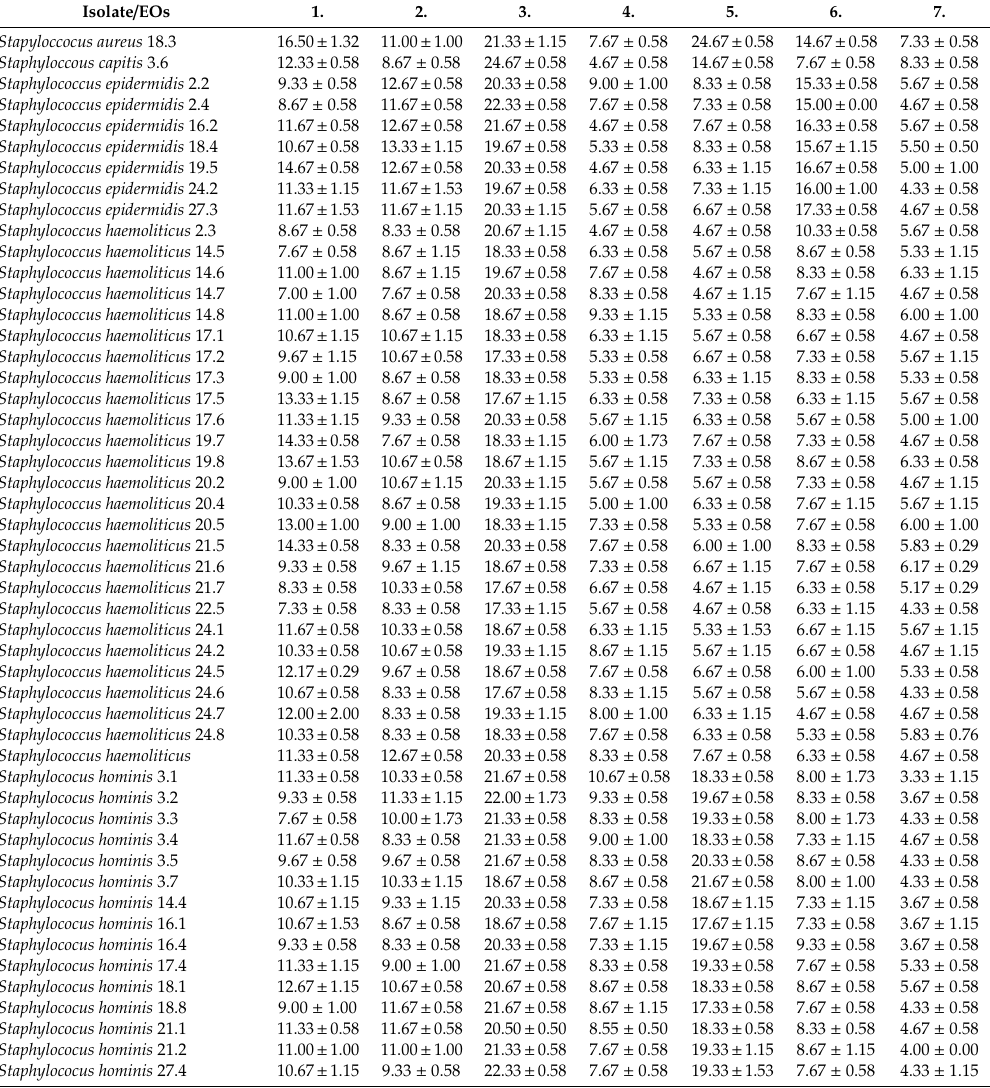
Table 3. Antimicrobial activity of essential oils (EOs) with disc di ff usion method in mm. Isolate /